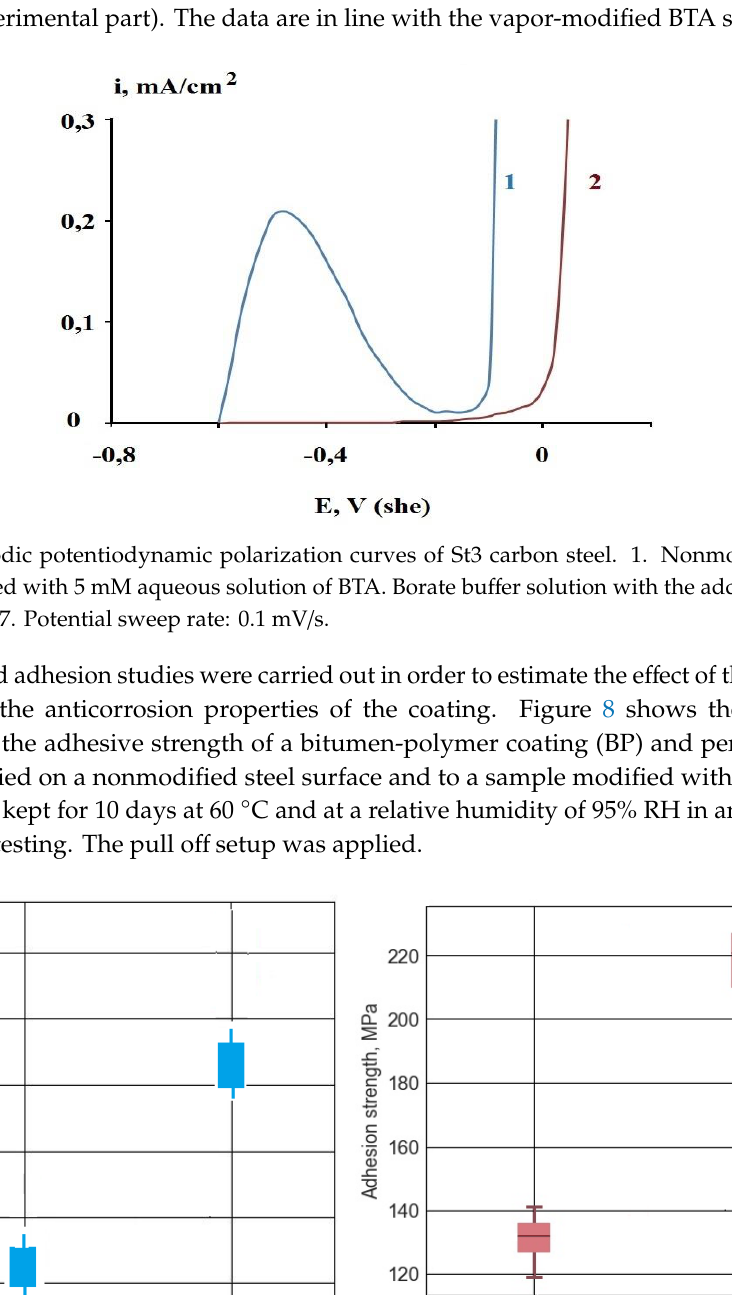
Figure 6. FTIR spectrum of the surface of carbon steel modified in 5 mM aqueous BTA solution.